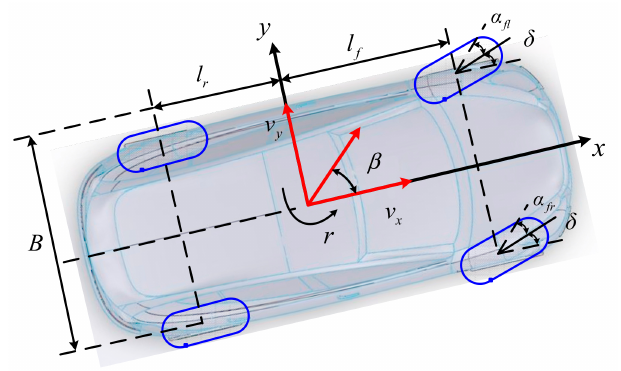
Figure 1. The vehicle model: top